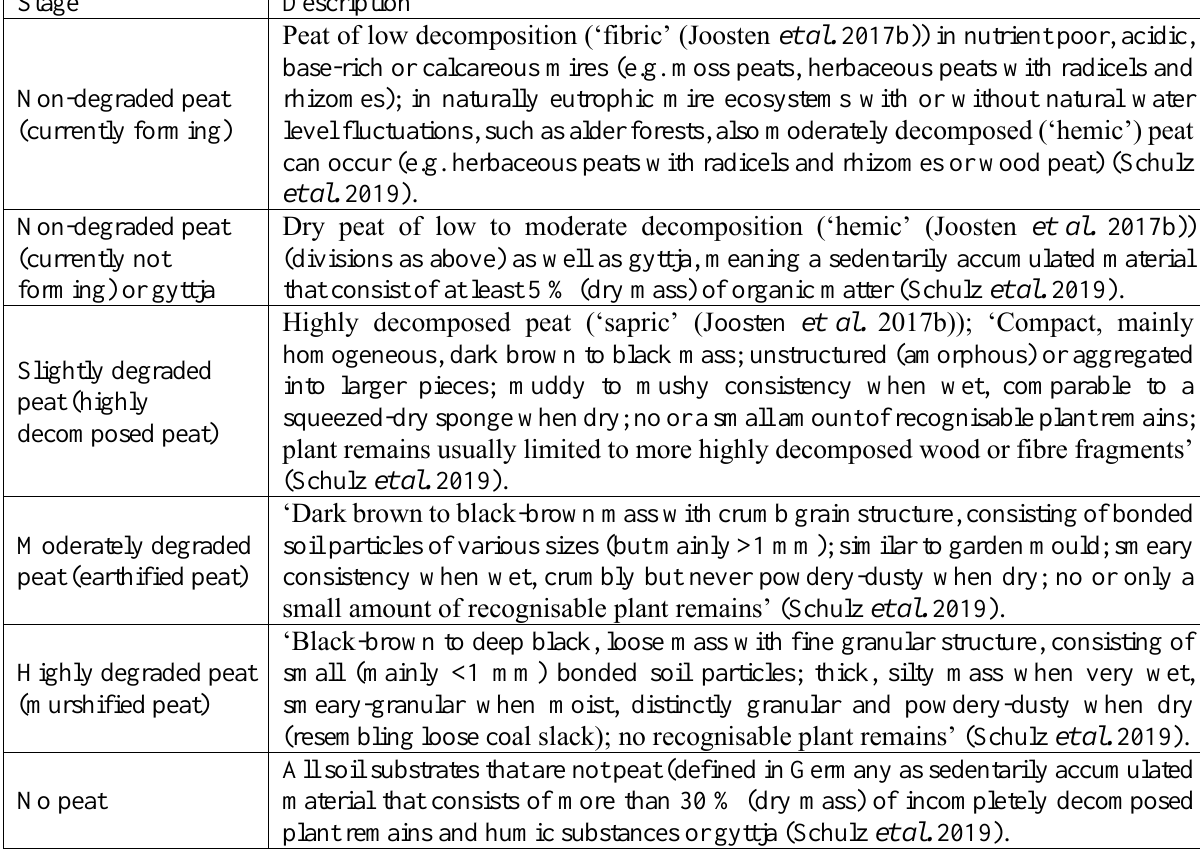
Table 5. Stages of peat topsoil (uppermost 30 cm) degradation from non-degraded peat (currently forming) to no peat.